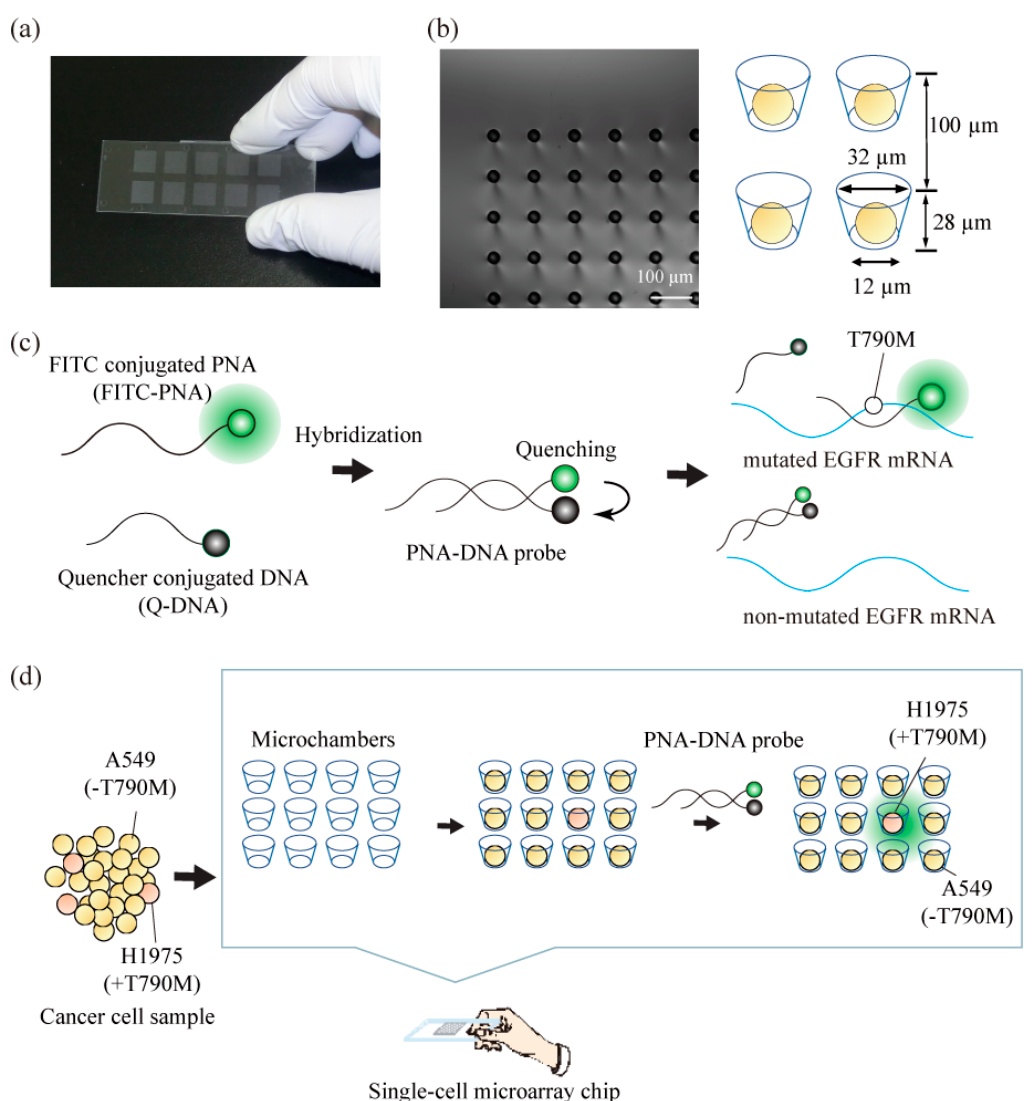
Figure 1. Schematic concept for the analysis of single nucleotide-mutated cancer cells. ( a ) Photograph of a real single-cell microarray chip device, which was made with polystyrene and consists of 62,410 microchambers (upper diameter: 31–40 µm, lower diameter: 11–20 µm, depth: 28 µm, pitch: 100 µm). Each single-cell microarray chip consisted of 10 different-sized patterns of clusters, and each cluster consisted of 6241 (79 × 79) microchambers. Each microchamber had the shape of a circular cone frustum. ( b ) Microscopic image of microchambers (upper diameter: 32 µm, lower diameter: 12 µm) of one cluster in the single-cell microarray chip. The picture shows single lung cancer cells occupying each microchamber. ( c ) Principle of target single nucleotide-mutated epidermal growth factor receptor (EGFR) mRNA detection with a peptide nucleic acid (PNA)-DNA probe. ( d ) Schematic process for the analysis of mutation-harboring cancer cells at the single-cell level using our original techniques combined with a single-cell microarray chip and a PNA-DNA probe.